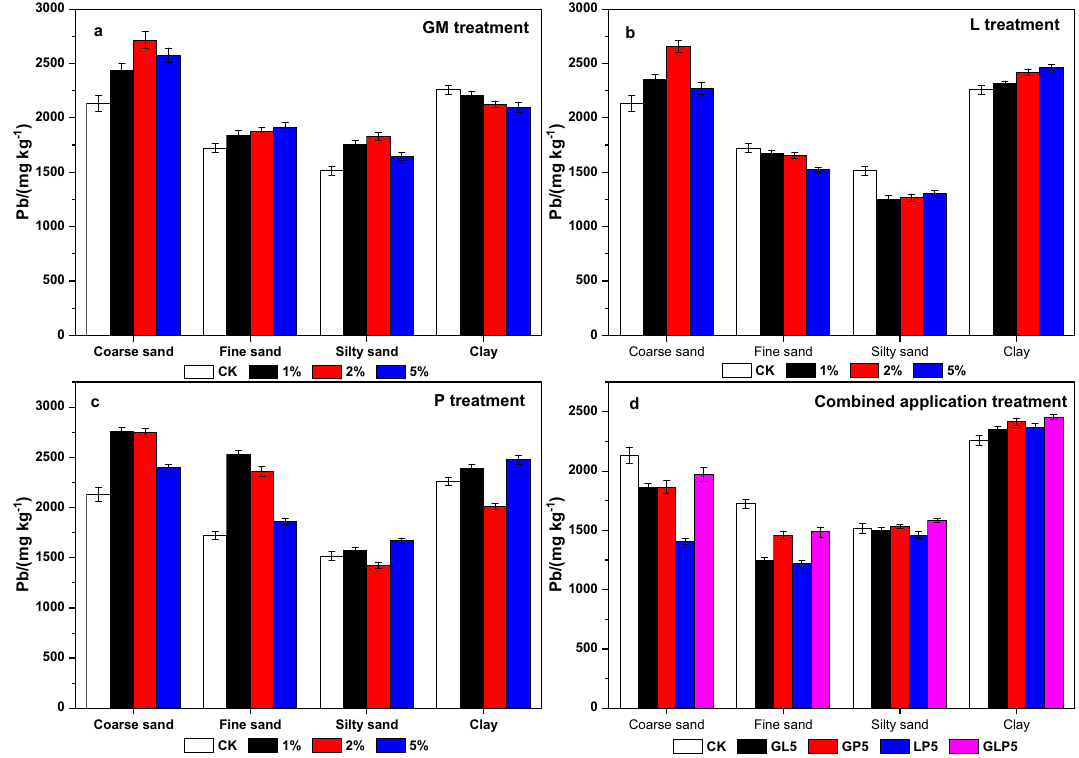
Figure 5. Content of total Pb in soil of different particle sizes under passivators (Origin